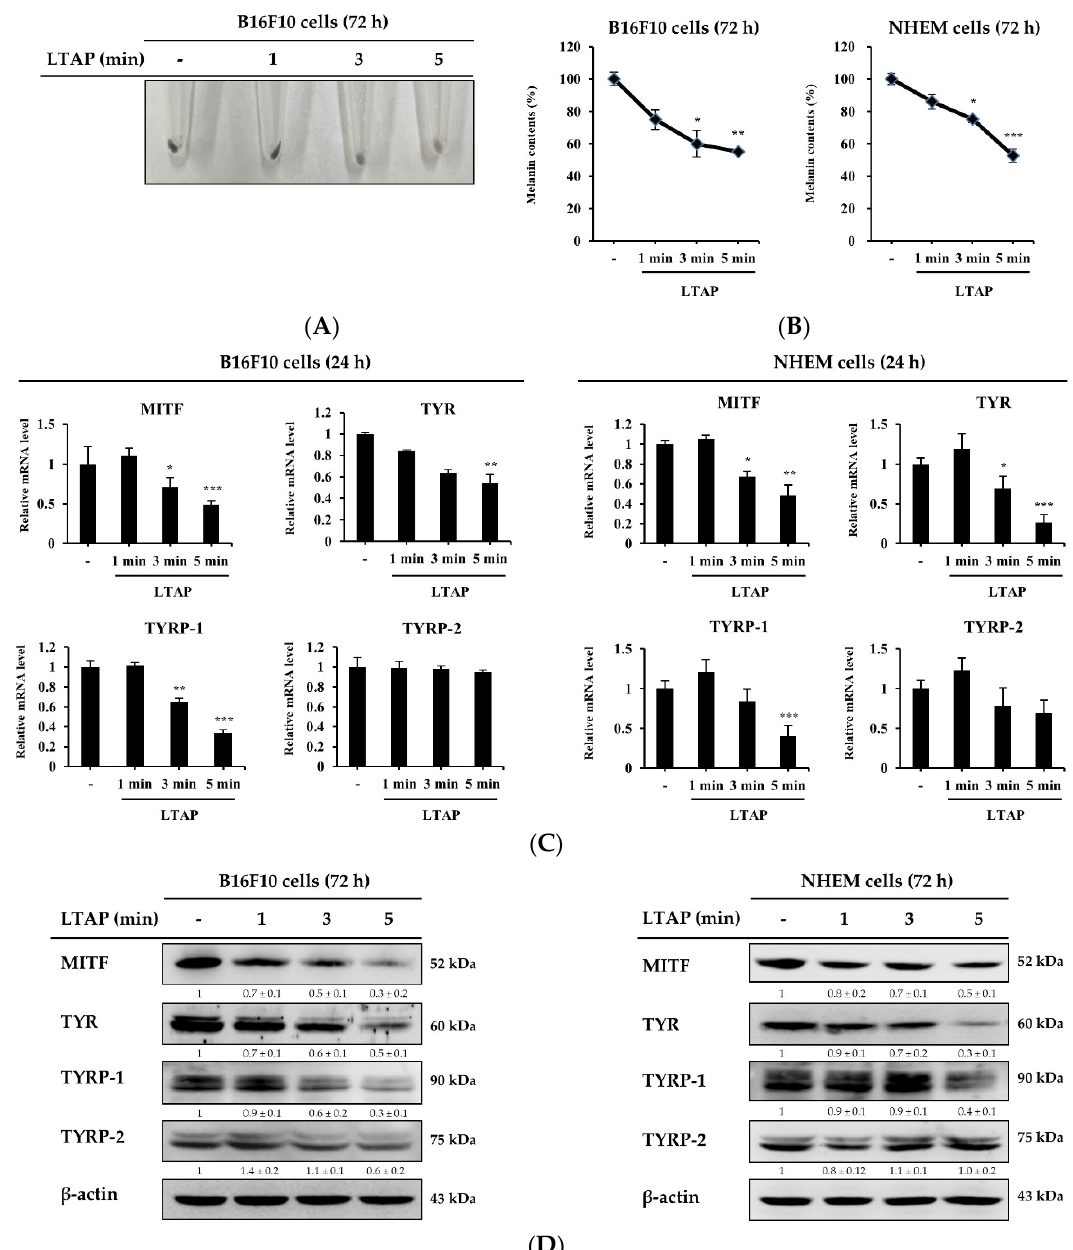
Figure 5. Effects of LTAP on melanogenesis in murine B16F10 cells and normal human epidermal melanocytes (NHEMs). ( A ) B16F10 cells were exposed to LTAP for 1, 3, or 5 min, and incubated further for 72 h. Cells were harvested and images were taken. ( B ) The melanin content in B16F10 cells and NHEMs was measured at 450 nm. * p < 0.05, ** p < 0.01, *** p < 0.001 (control vs. LTAP-exposed cells). ( C ) B16F10 cells and NHEMs were exposed to LTAP for 1, 3, or 5 min, and further incubated for 24 h. The expression levels of microphthalmia-associated transcription factor (MITF), tyrosinase ( TYR ) and tyrosinase-related protein-1, 2 (TYRP-1, 2 ) were measured by qRT-PCR analysis. Data are the means ± SD and represent three independent experiments. * p < 0.05, ** p < 0.01, *** p < 0.001 (control vs. LTAP-exposed cells). ( D ) Cells were exposed to LTAP for 1, 3, or 5 min, and incubated for 72 h. The expression of MITF, TYR and TYRP-1, 2 was evaluated by Western blotting. β -actin was used as a loading control. Numerical values on the blots represent DU. The control was normalized to 1 DU. All data represent three independent experiments.